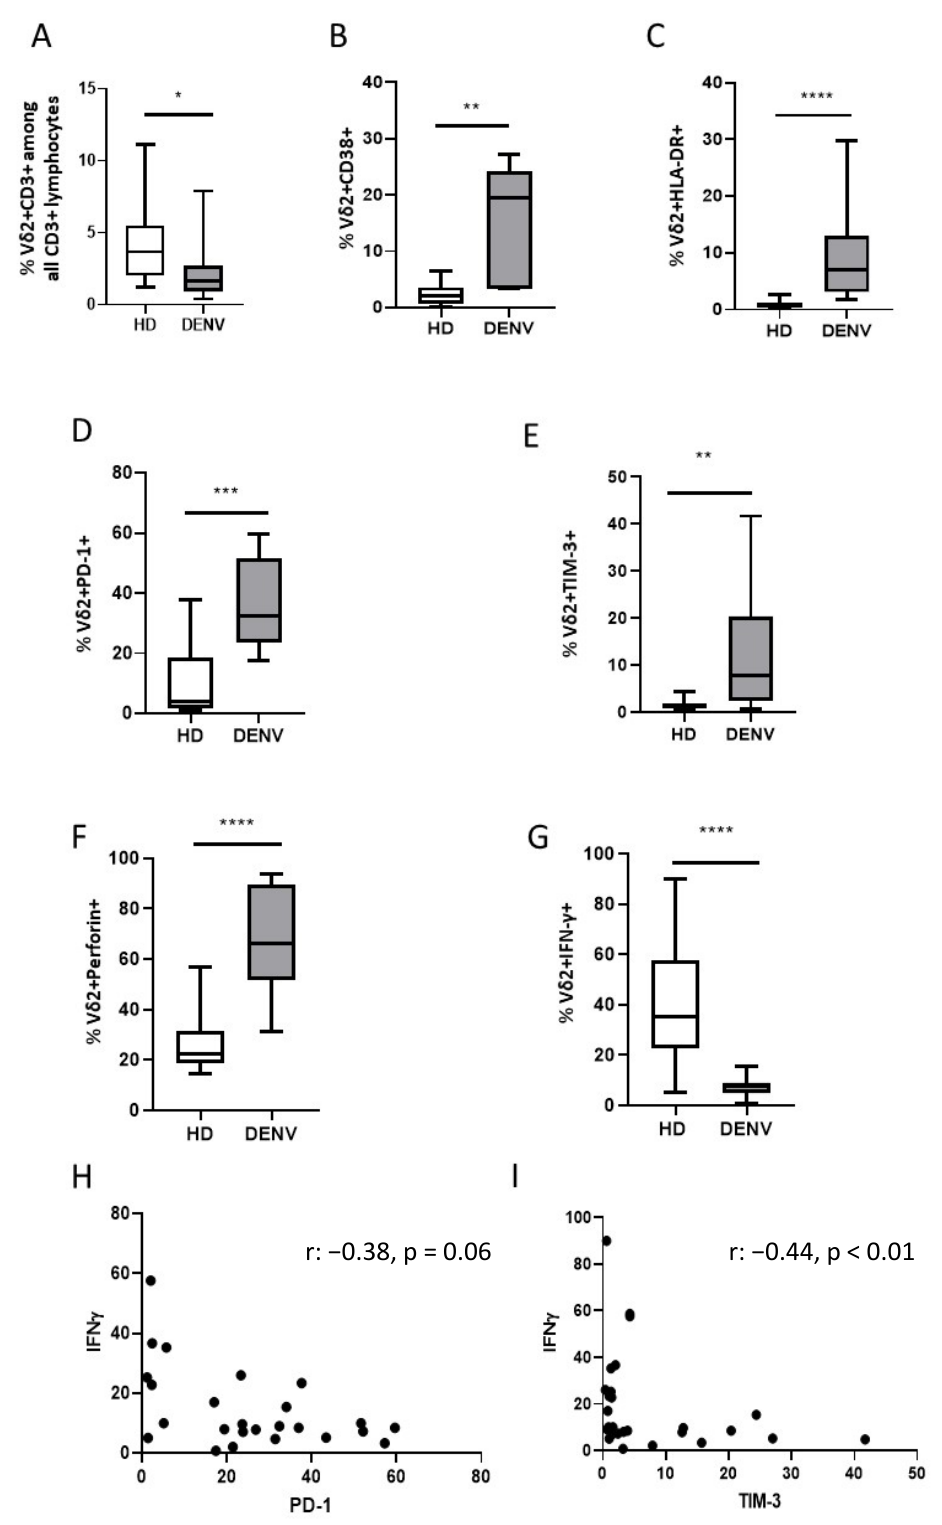
Figure 1. Phenotypic and functionality characteristics of γδ T cells. Frequency ( A ) activation markers ( B , C : CD38, HLA-DR), exhaustion markers ( D , E : PD-1, TIM-3), and functionality ( F , G : perforin, IFN- γ ) were performed on PBMC of DENV patients and HD by multiparametric flow cytometry. Correlations ( H , I : IFN- γ /PD-1; IFN- γ /TIM-3) were performed by Spearman test for non-parametric data.*: p < 0.05; **: p < 0.01; ***: p < 0.001; ****: p < 0.0001.